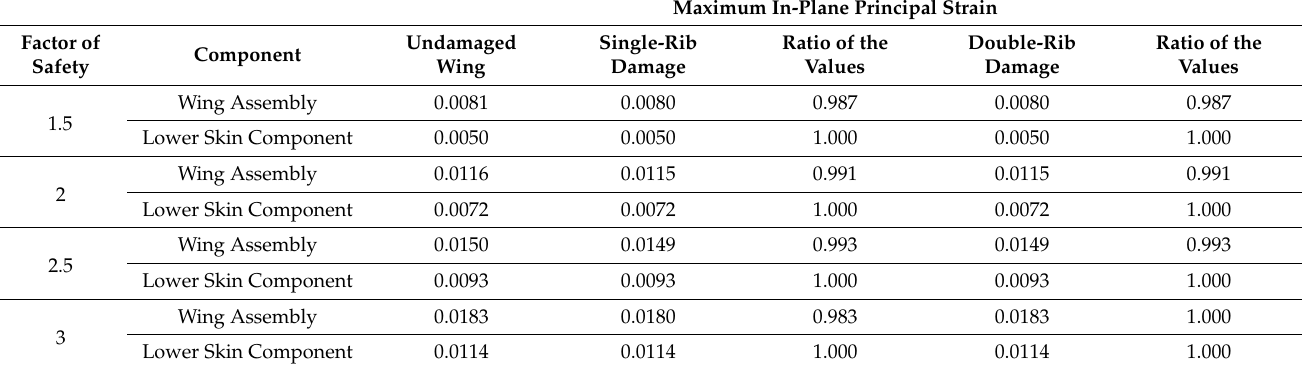
Table 20. Comparison of maximum in-plane principal strain in the undamaged wing and wing containing rib damage.